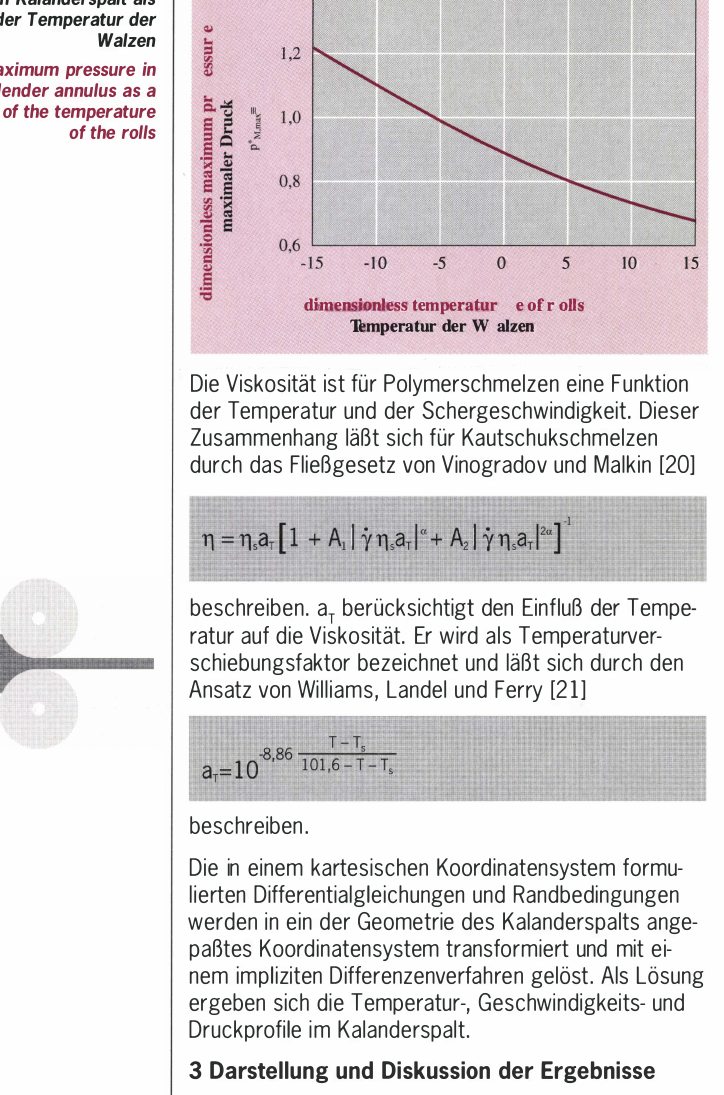
Fig. 3: Horizontal velocity in the calender